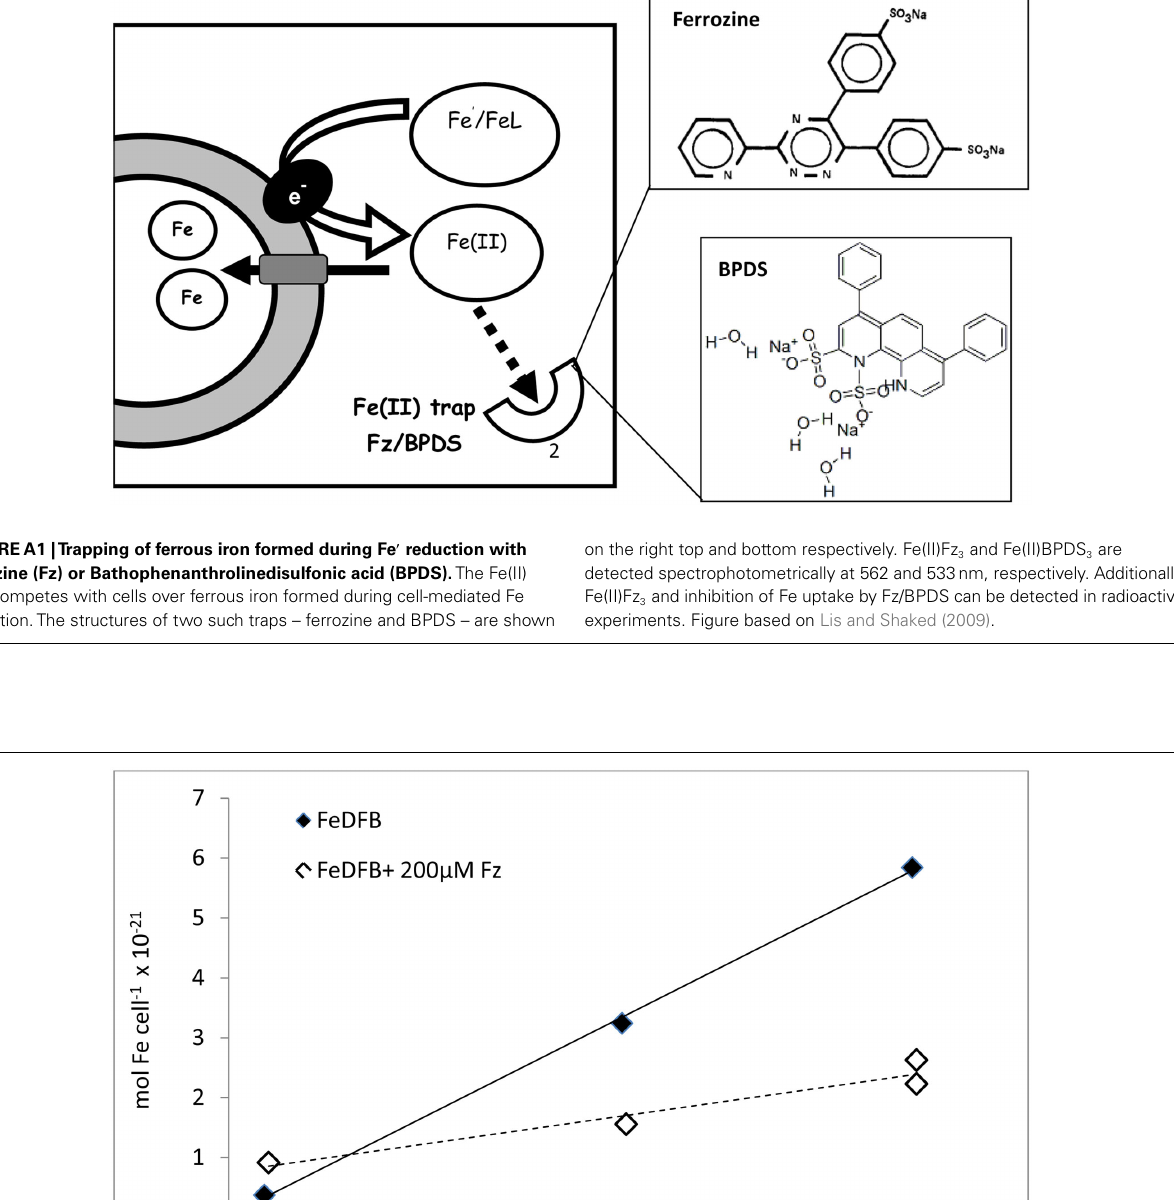
from 90nM 55 FeDFB by iron limited Synechococcus WH8102 was inhibited in the presence of 200 μ M Fz.The inhibitory effect stems from the trapping of Fe(II) formed through cell surface enzymatic reduction during Fe